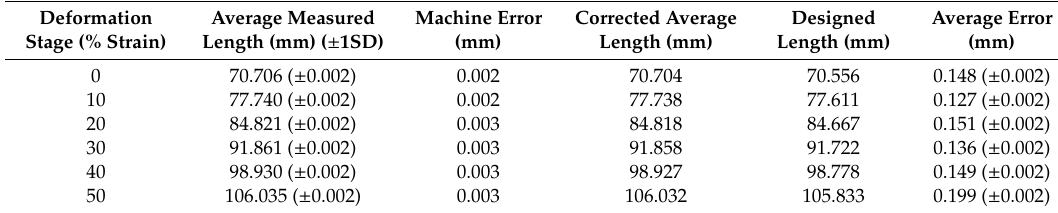
Table 2. Pattern Length Measurements.